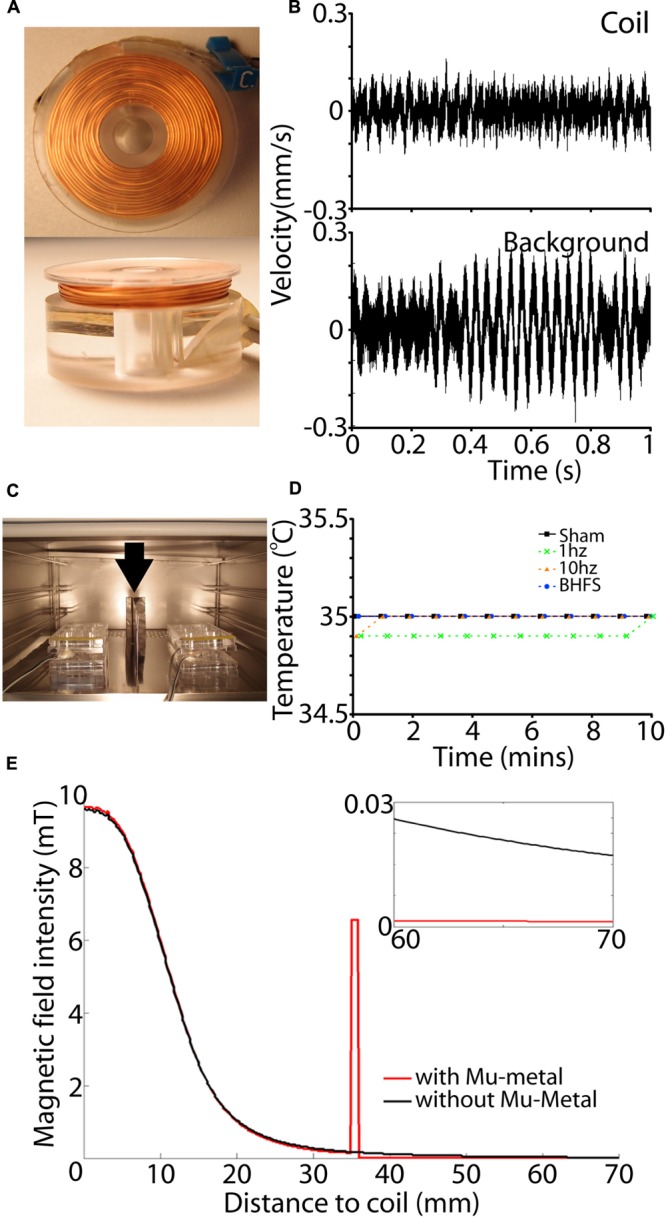
Coil set-up and magnetic shielding. (A) View of a single coil from the top (top panel) and side (bottom panel). (B) Vibration measurement of the coil (top) and background surface (below) in mm/s as measured by a single point vibrometer with OFV-534 compact sensor head for high optical sensitivity. Vibration amplitude of the coil is within background vibration. (C) View of the coil set-up within the incubator. A sheet of Mu-metal (min 1 mm thickness) is placed between adjacent cultures (vertical arrow). Also two wires can be seen passing to each six-well plate. This is because each coil is driven by a separate RL circuit. (D) Measurements of coil temperature during the 10 min stimulation period. For all frequencies and sham (unactivated coils) there was no temperature rise above that of the incubator (35°C). (E) Effect of Mu-metal on the magnetic field. Black lines indicate a produced magnetic field without Mu-metal shielding at a horizontal distance from the center of the active coil. Red line shows the magnetic field in correspondence with a Mu-metal shielding at 35 mm from the coil. Magnetic field intensity is concentrated by Mu-metal, leading to complete shielding with no detectable magnetic field at adjacent cultures beyond that distance (small inset).